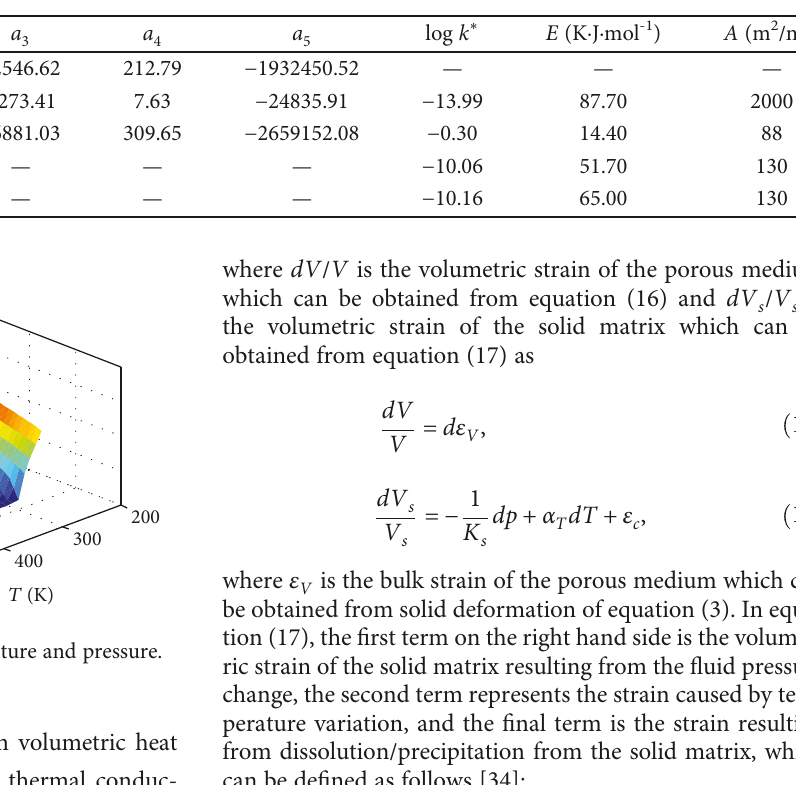
Table 2: Parameters for the mineral reactions in equations (5) – (7).